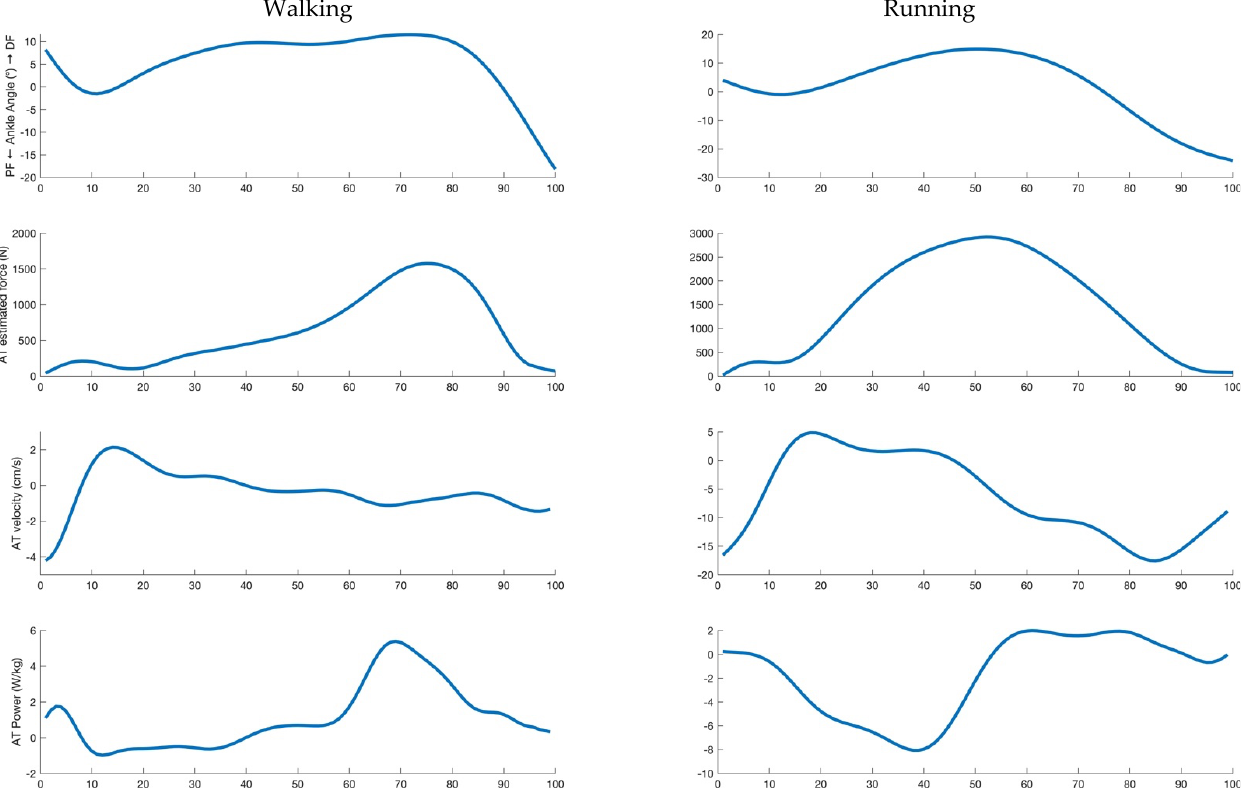
Figure 1. From top to bottom: ankle angle, Achilles tendon force, Achilles tendon velocity and Achilles tendon power during the stance phase of walking (panels on the left ) and running (panels on the right ) for a representative subject at a speed of about 7.5